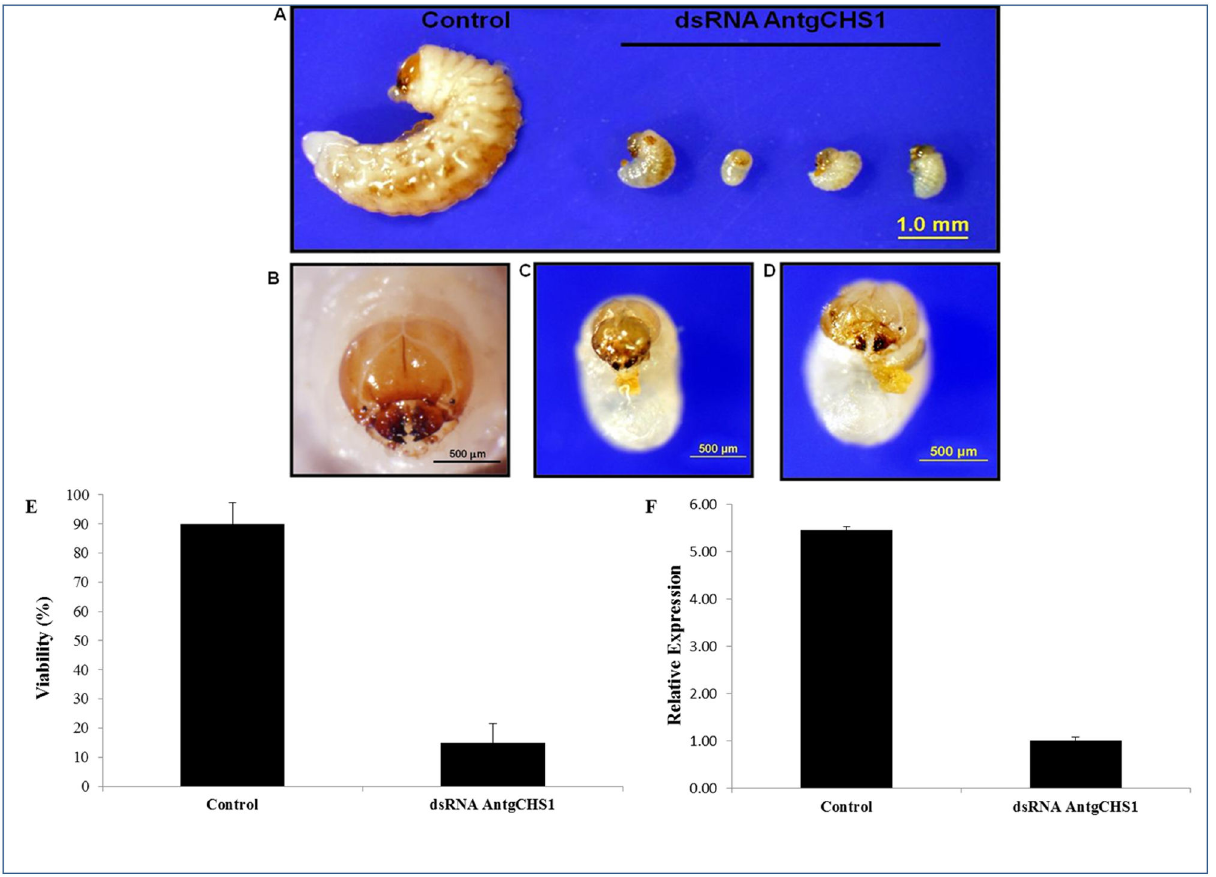
Figure 8. Effect of AntgCHS1 on A. grandis on oviposition. Larvae that emerged from eggs laid by females previously microinjected with 200 ng of either GUS (control) or AntgCHS1 dsRNA (A). After egg hatching, larvae were fed in artificial diet for 7 days. Details of head capsule show malformations in AntgCHS1 dsRNA-treated larvae (C and D) when compared to control (B). The viability was reduced (E) and as well as the number of transcripts of AntgCHS1 (F) in eggs laid by females previously microinjected with AntgCHS1